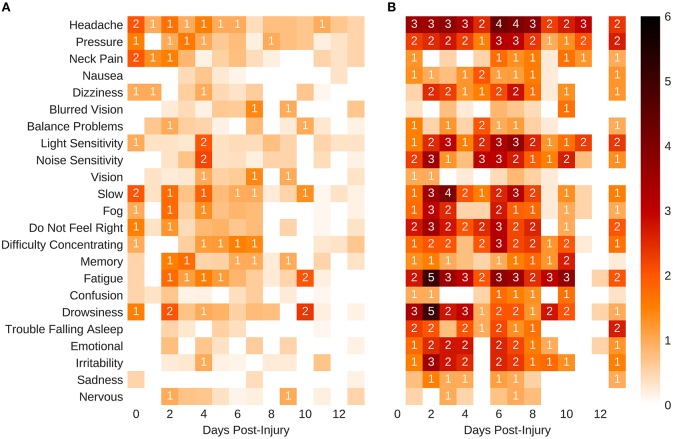
Self-reported mean symptom scores. (A) Males. (B) Females. The shaded squares without a value are below 1.